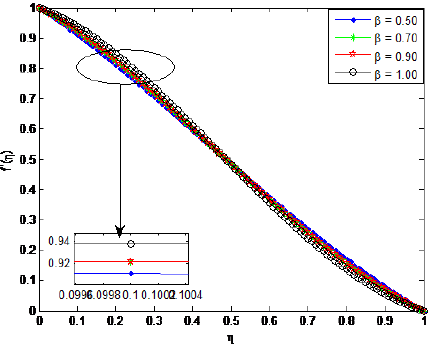
Figure 8. Influence of β on dimensionless velocity